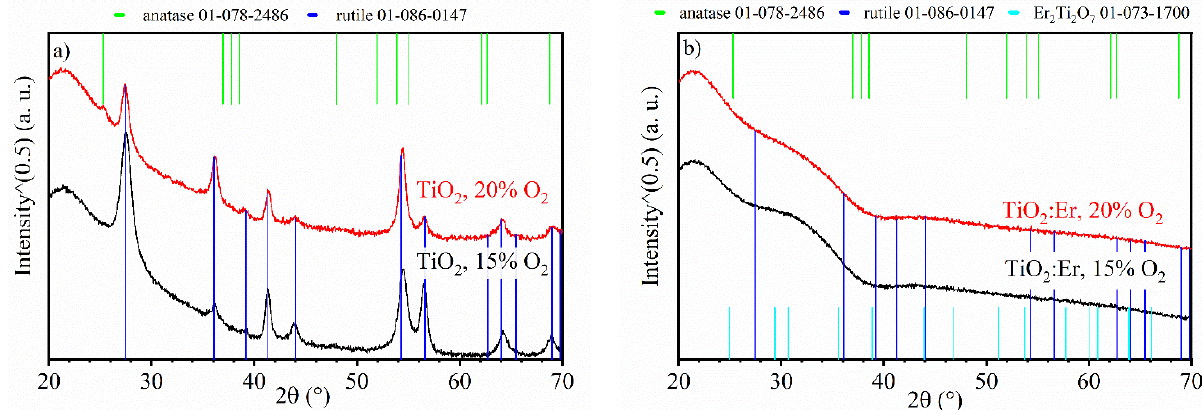
Figure 1. XRD patterns recorded for the thin films of: ( a ) pure TiO 2 deposited at 15% O 2 (black curve) and 20% O 2 (red curve) and ( b ) Er-doped TiO 2 deposited at 15% O 2 (black curve) and 20% O 2 (red curve). Positions of reference peaks are marked by vertical lines. Reference patterns are from anatase 01-078-2486, rutile 01-086-0147 and Er 2 Ti 2 O 7 01-073-1700 cards.